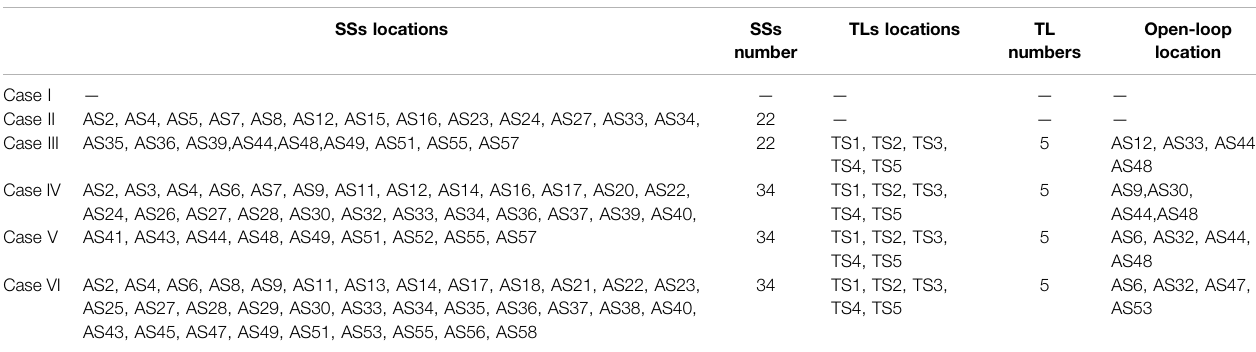
TABLE 11 | The installation of bus 4 for the six cases.